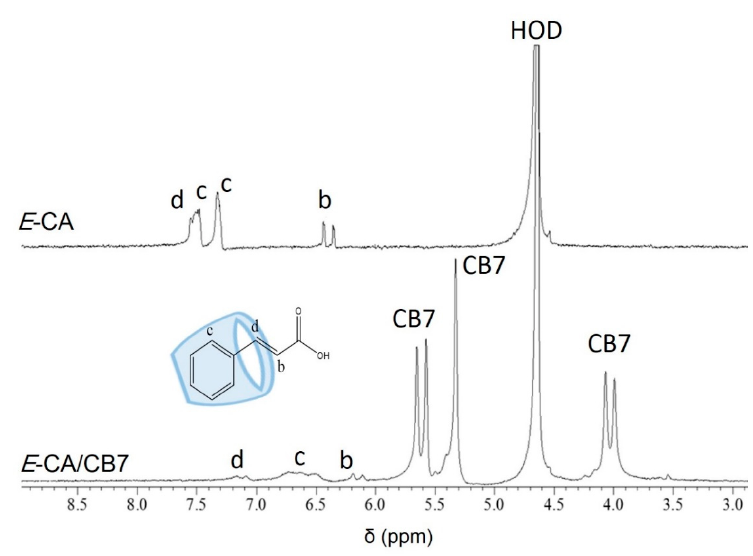
Figure 3. 1 H NMR spectra of E -CA (3.25 mM) with CB7 (two equiv.) in D 2 O of pD 2.5 at 298 K (400 MHz). Solvent, guest (b − d), and CB7 peaks are indicated.